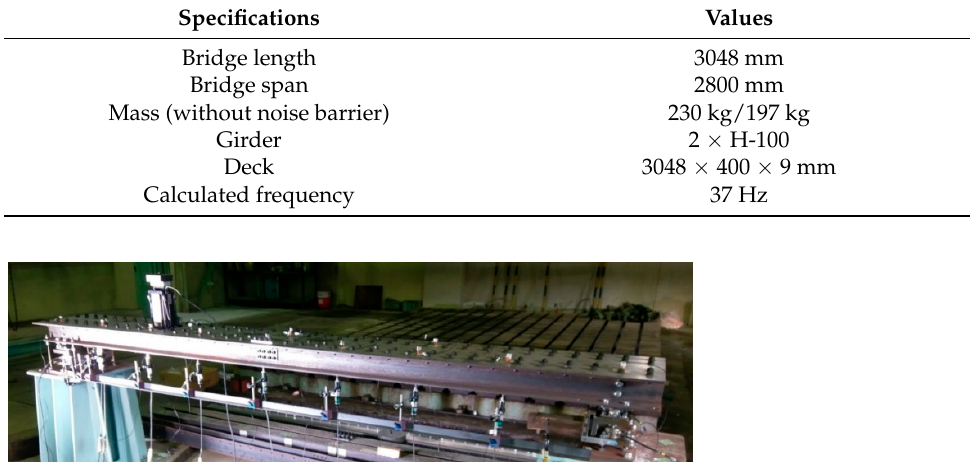
Figure 3. Picture of the model